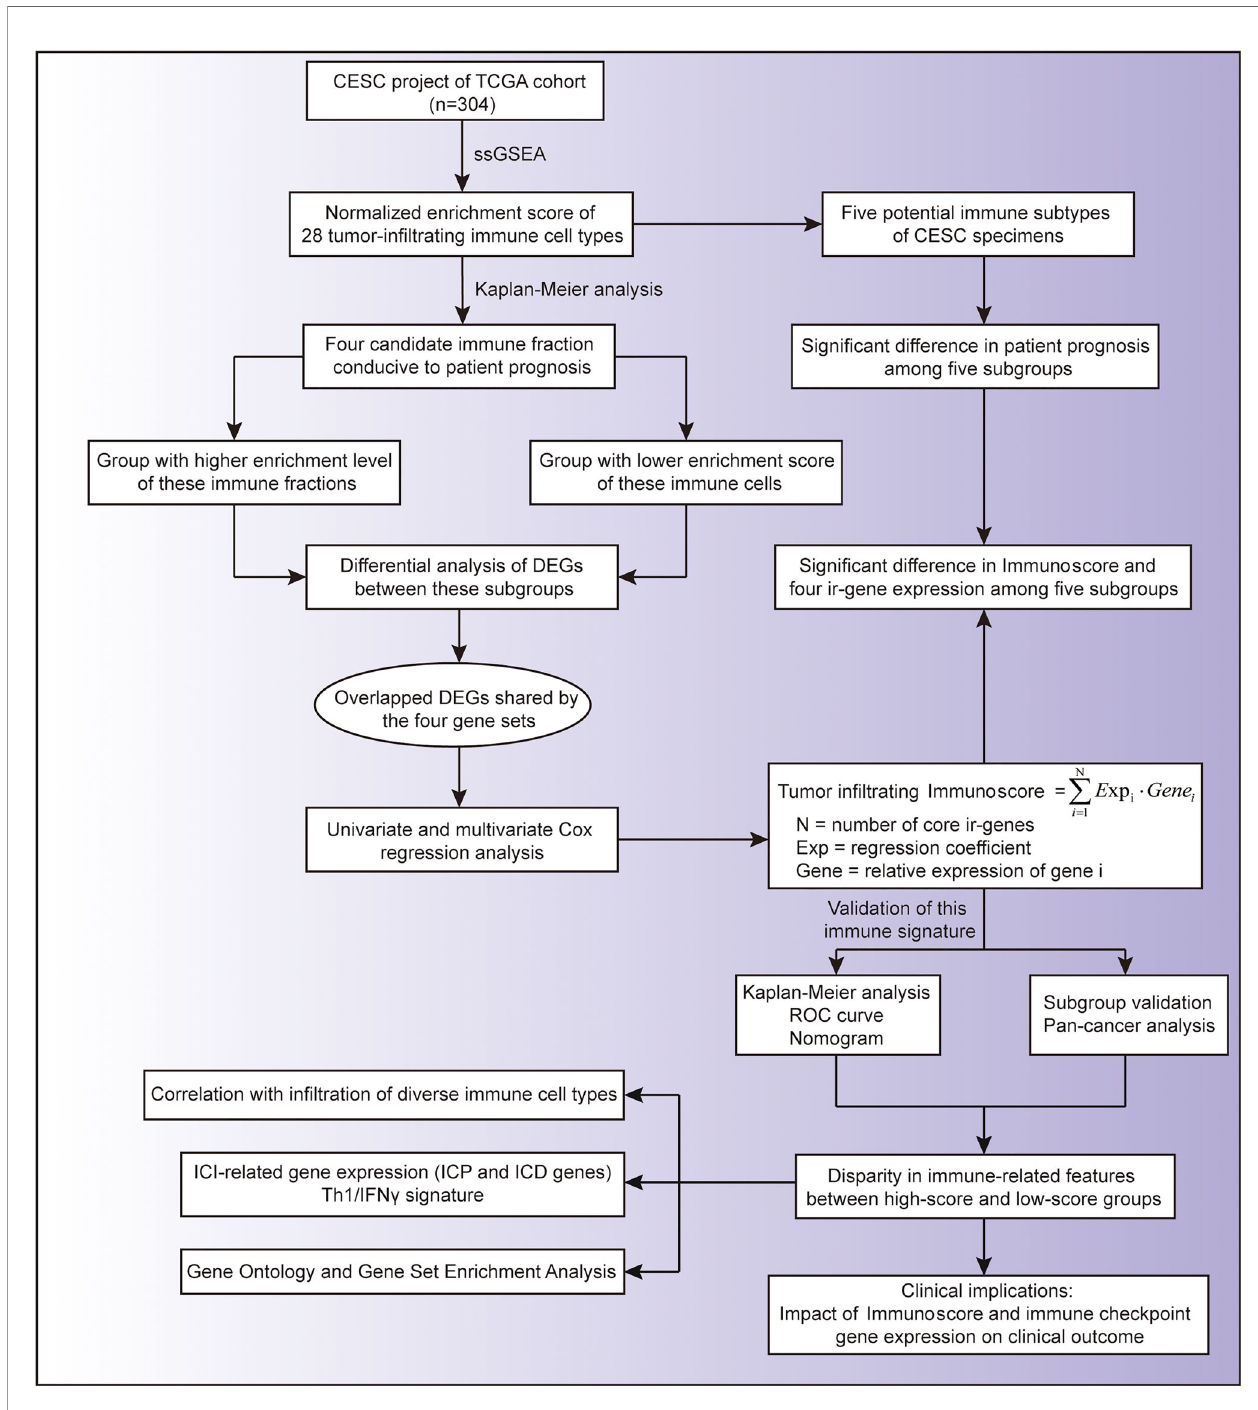
FIGURE 1 | Flow chart of this